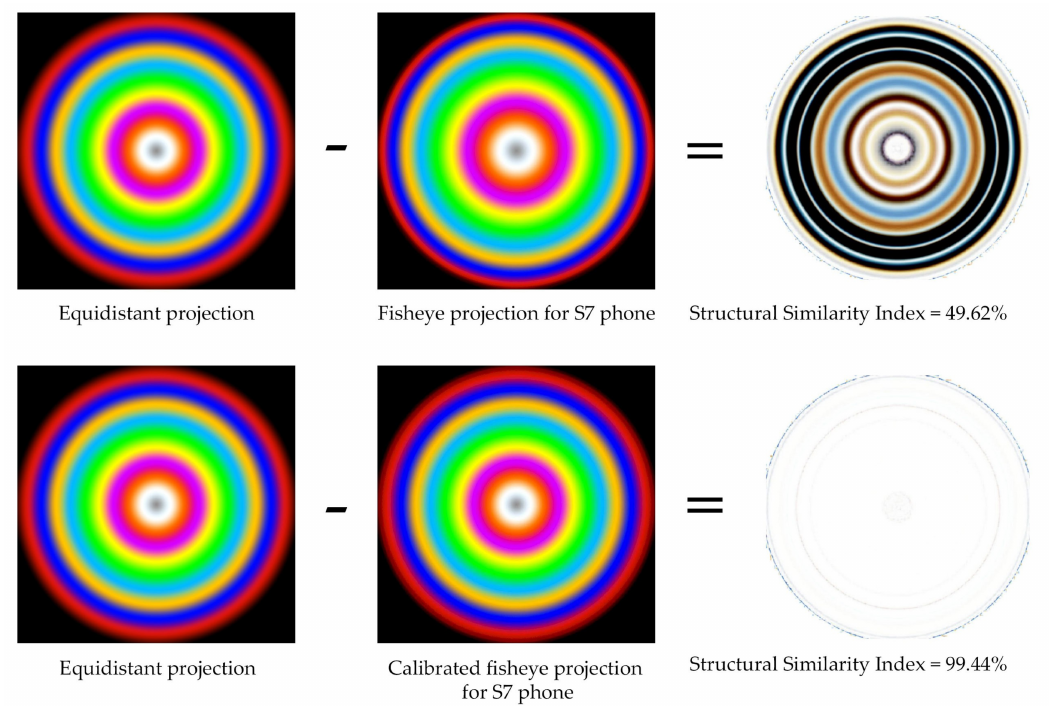
Figure 19. Shows the structural similarity index (SSIM) of the mobile fisheye